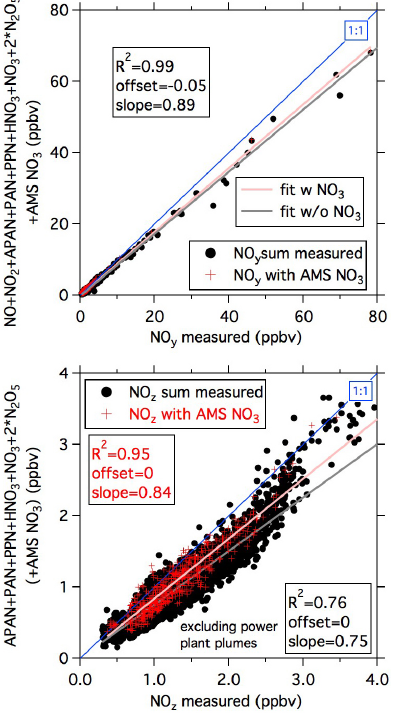
Figure 7. NO y and NO z ( = NO y − NO x ) budgets for the NOAA WP-3D flight on 16 June 2013 with and without aerosol